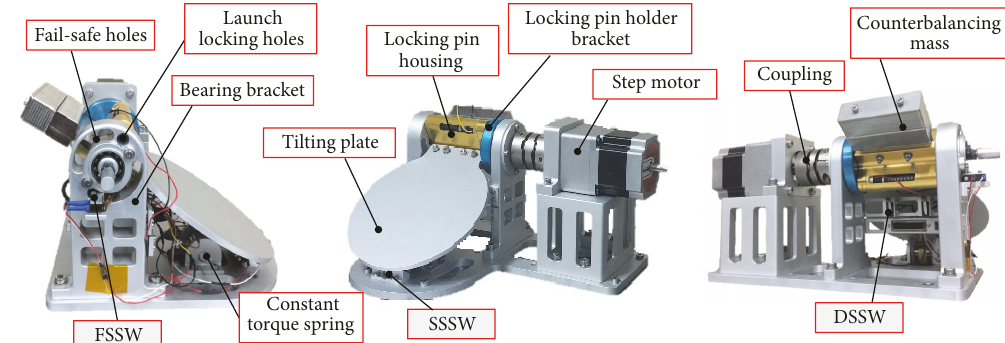
Figure 5: Manufactured development model of the tilting calibration mechanism.